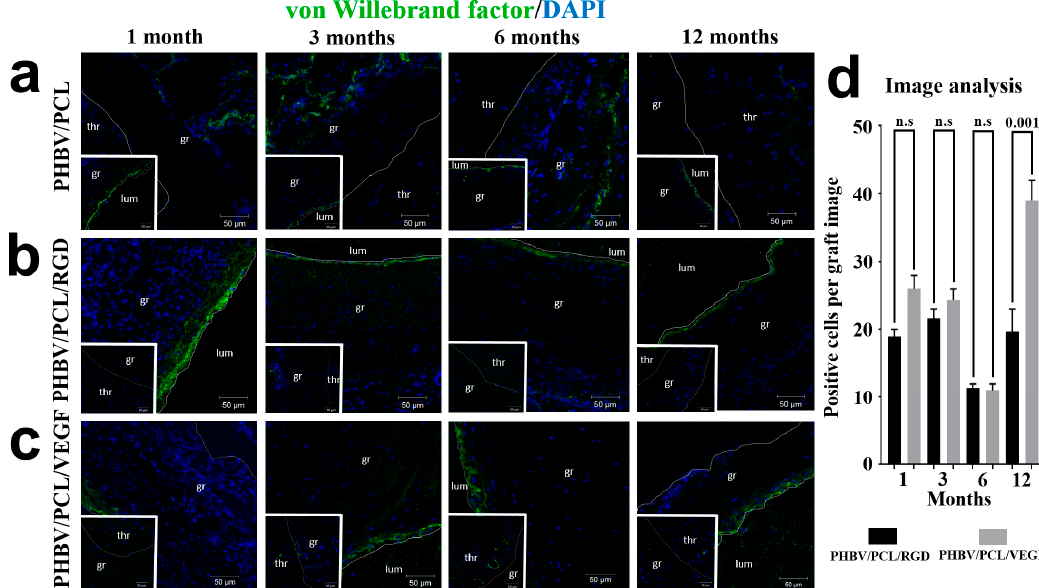
Figure 4. Combined von Willebrand factor (vWF, green) and DAPI (blue) staining. Representative images of: ( a ) PHBV/PCL grafts; ( b ) PHBV/PCL/RGD grafts; ( c ) PHBV/PCL/VEGF grafts. Thr is for thrombus, gr is for graft, lum is for lumen. Images of corresponding patent PHBV/PCL along with occluded PHBV/PCL/RGD and PHBV/PCL/VEGF grafts are presented as bottom inserts; ( d ) Quantitative image analysis, data are represented as mean with range, p -values are reported numerically, n.s. is for not significant, two-tailed Student’s t -test. Non-modified PHBV/PCL grafts were not included in the analysis, since their luminal surface was devoid of vWF + cells, while the single positive cells within the graft wall were irrelevant for the assessment of